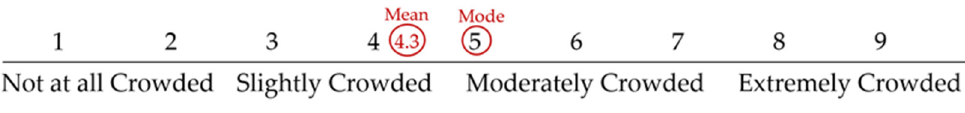
Figure 3. Overall crowding level scale, shown with mean and mode values from survey responses. An independent sample t-test was run to identify the differences in the crowding level mean between user types, (i.e., snorkelers and scuba divers). However, no statistical differences were detected between these groups ( p = 0.938). Consequently, the data showed that snorkelers (4.3 ± 0.1) and scuba divers (4.3 ± 0.2) had the same average crowding